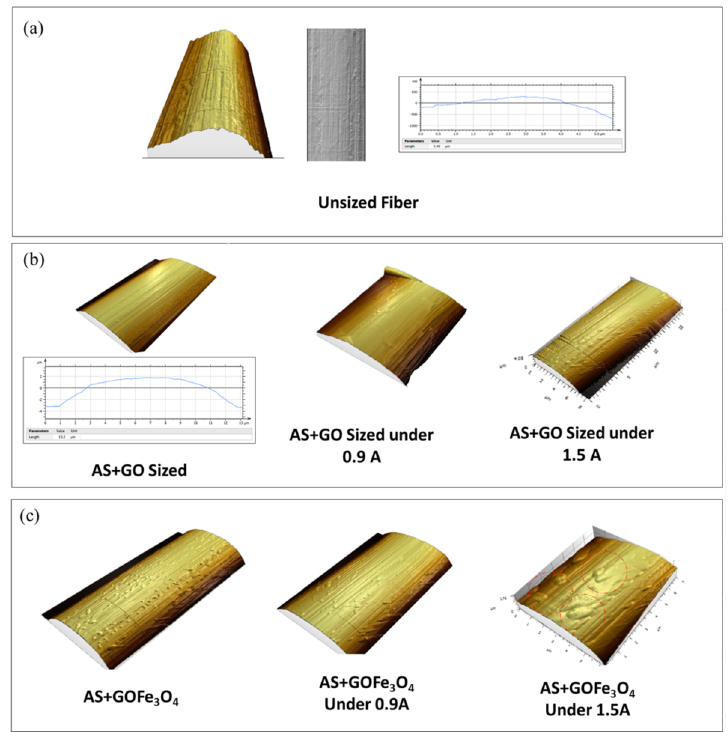
Figure 7. Effect of magnetic field on the coating quality of the fibers with the GO, atomic force microscopy (AFM) topographies of ( a ) unsized fiber for reference; ( b ) sized fiber with AS + GO; ( c ) sized with AS + GO under a magnetic field powered under 1.5 A and 0.9